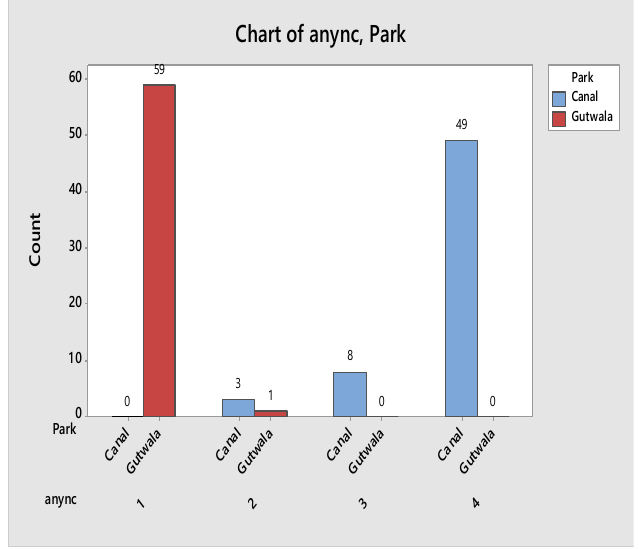
Figure 9: Bar Chart of BP in two Parks It was observed in fig. 9 that 6 out of 60 visitors responded highly affected by the blood pressure due to noise pollution while 4 out of 60 showed mild and 1 out of 60 showed low response in the site-1 Canal Park, contrarily, all sampled 60 visitors in the Site-2 Gat Wala Park did not show any symptom of stress due to noise pollution, which mean the mostly response observed in this regard was nil (Blood Pressure) and confirming that the environment of the Gat Wala Park is peaceful and calm while environment of the Canal Park is noisy and affecting health of the visitors and similarly other symptoms were investigated through this study.